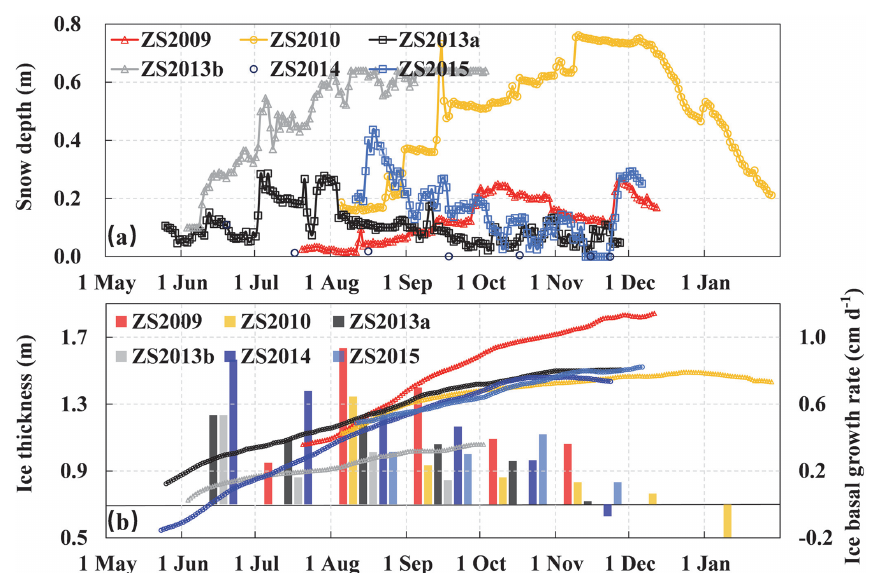
Figure 4. Seasonal evolution of (a) the snow depth and (b) the ice thickness (lines, left axis) off ZS derived from CRREL-IMB and SIMBA observations, with the bars in panel (b) denoting the monthly ice basal growth rates (right axis). The snow depth of ZS2014 was obtained from in situ measurements and showed as blue